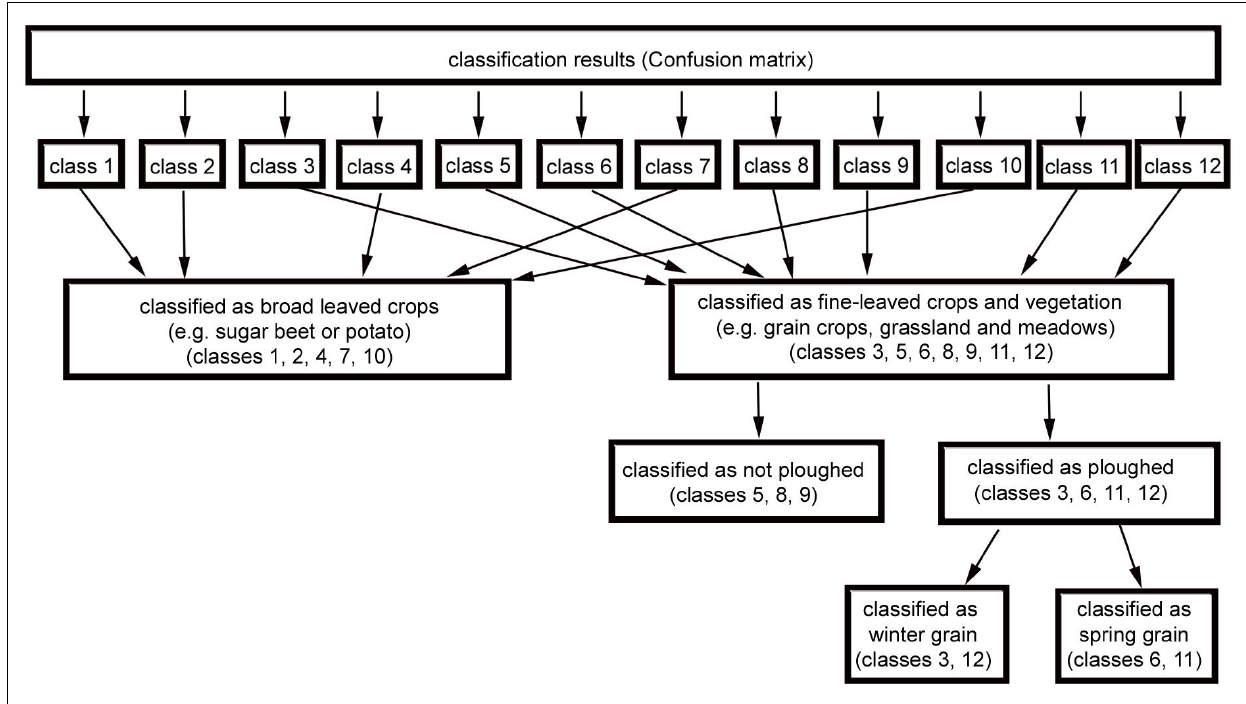
Figure 6. Definition of class groups for accuracy assessment